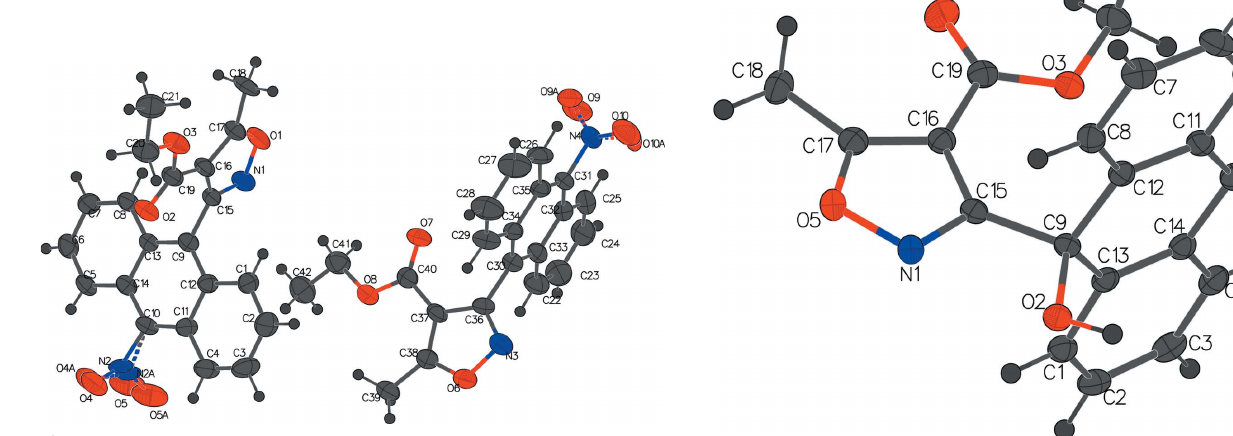
Figure 2 The asymmetric unit of compound (I) showing displacement ellipsoids drawn at the 50% probability level. The structure on the left is molecule A and that on the right is molecule B .